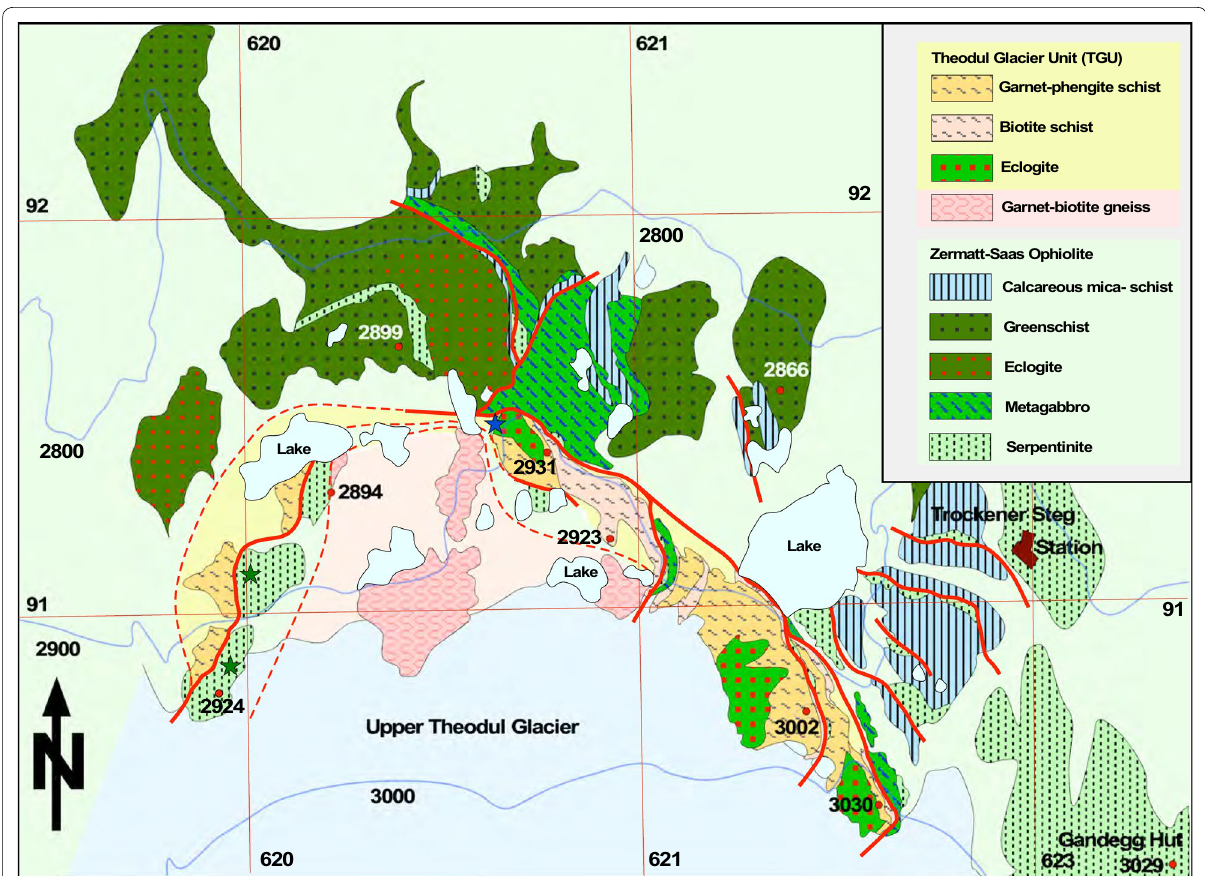
Fig. 3 Geological map of the Trockener Steg area with the sampling location of eclogite of SW9 (blue star) and two rodingite occurrences (green stars). The key samples of the Grt-Ph schists KB860 and OK-Z133 (Bucher et al. 2019) have been collected at the SE-wall of point 3030 (see also Fig. 4) (OK samples from Klemm 2005). Note that the map is a revised and improved version of the local geological map in Weber and Bucher (2015). Easting and northings according to the Swiss coordinate